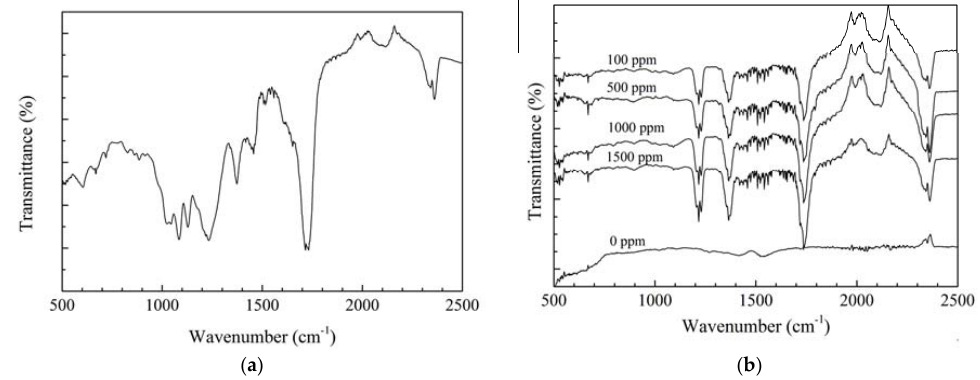
Figure 2. ATR FT ‐ IR results of ( a ) as ‐ prepared Aganonerion polymorphum leaf ‐ ethyl acetate extract (APL ‐ EAE) glue; and ( b ) steel surfaces after 24 h immersion in simulated ethanol fuel blend solutions containing different APL ‐ EAE concentrations.